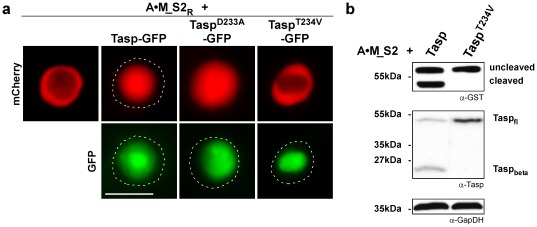
Activity and complex formation of Taspase1 and catalytically inactive mutants. A.Taspase1 processing of AF4•MLL substrates in leukemic cells. Co-transfection of Tasp-GFP resulted in proteolytic cleavage and nuclear accumulation of the red fluorescent biosensor, A•M_S2R, in K562 cells. In contrast, co-expression of TaspD233A-GFP leads to partial processing and nuclear translocation, while TaspT234V-GFP was completely inactive. Localization was analyzed 24 h post transfection. GFP/mCherry were visualized by fluorescence microscopy. Scale bars, 10 µm. B. Processing of AF4•MLL substrates. Co-transfection of Tasp resulted in proteolytic cleavage of the biosensor A•M_S2R in 293T cells as indicated by immunoblot. In contrast, TaspT234V was inactive in cis and trans. Proteins were visualized using α-GST or α-Taspase1 Abs. GapDH served as loading control. fl, unprocessed Taspase1; Taspβ, Taspase1 β-subunit.